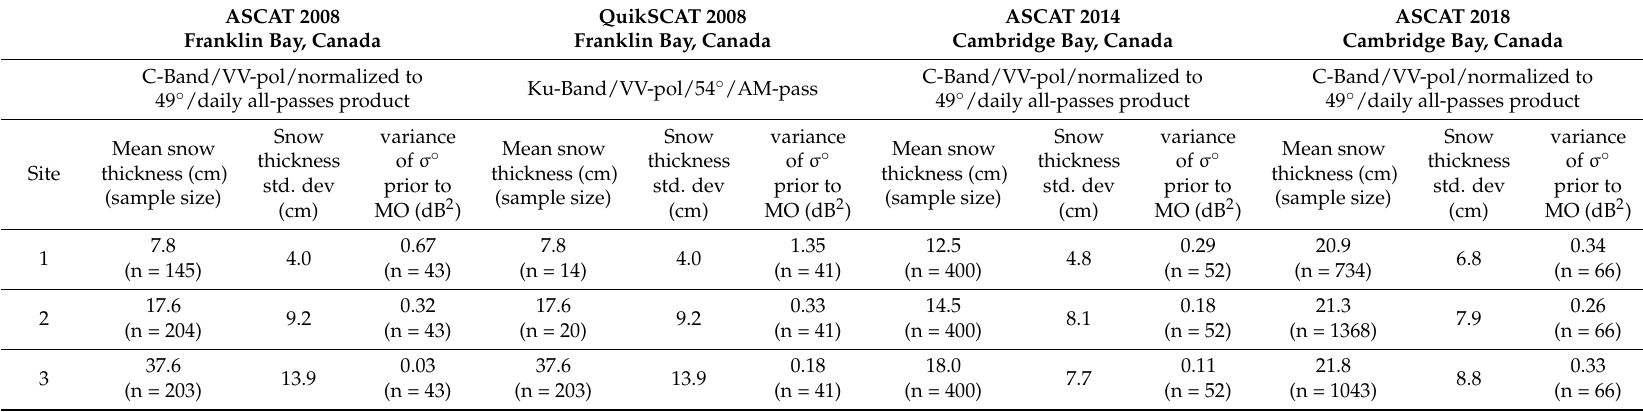
Table 1. Ku- and C-band scatterometer data used in case studies along with mean snow thickness, snow thickness standard deviation, snow thickness sample size, σ ◦ variance prior to melt onset and number of daily winter σ ◦ observations in time series.